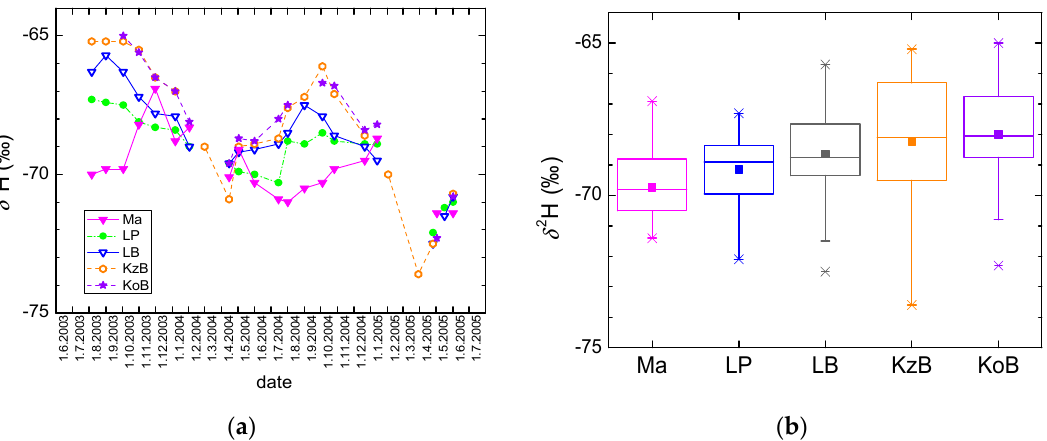
Figure 13. ( a ) δ 2 H values in the surface waters, 2003–2005, data from [10]; ( b ) box-plots of δ 2 H values at the same locations.